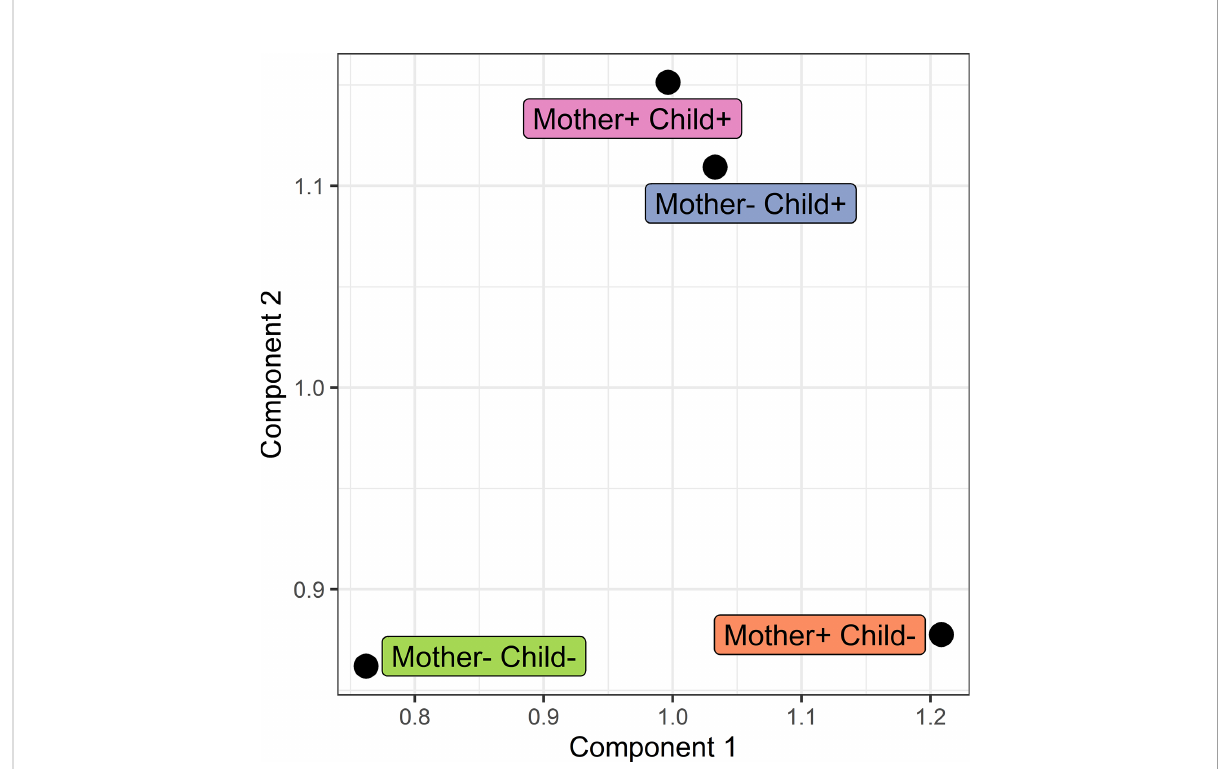
FIGURE 7 Score plot of the COVSCA model for the protein correlation network obtained using PCLRC of different groups based on maternal and child allergy status in the CHILD Cohort Study. Each point represents a protein-protein association network of one mother-child allergy group (+ indicates allergy, and - indicates no allergy). Protein importance for each component is shown in Figure 8. The groups with children who ultimately developed an allergy show similarities, whereas all the other groups show dissimilarities in correlation